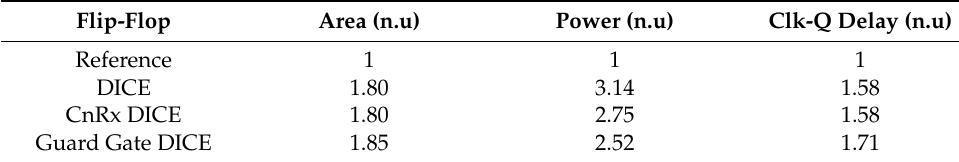
Table 1. Relative performance comparison of the proposed FF designs.